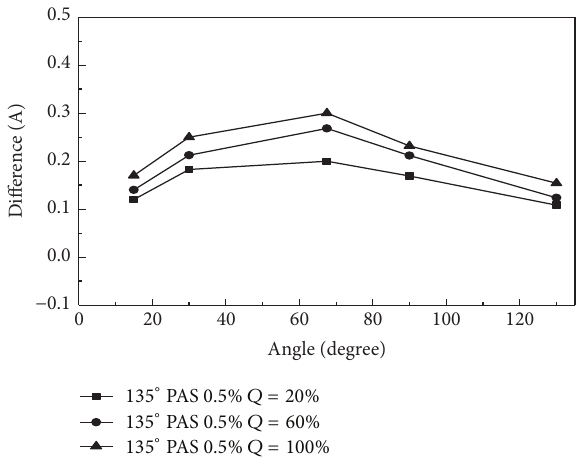
Figure 21: The PAS 0.5% angle of curved tube: difference diagram of various flows in 135 ∘ curved tube.